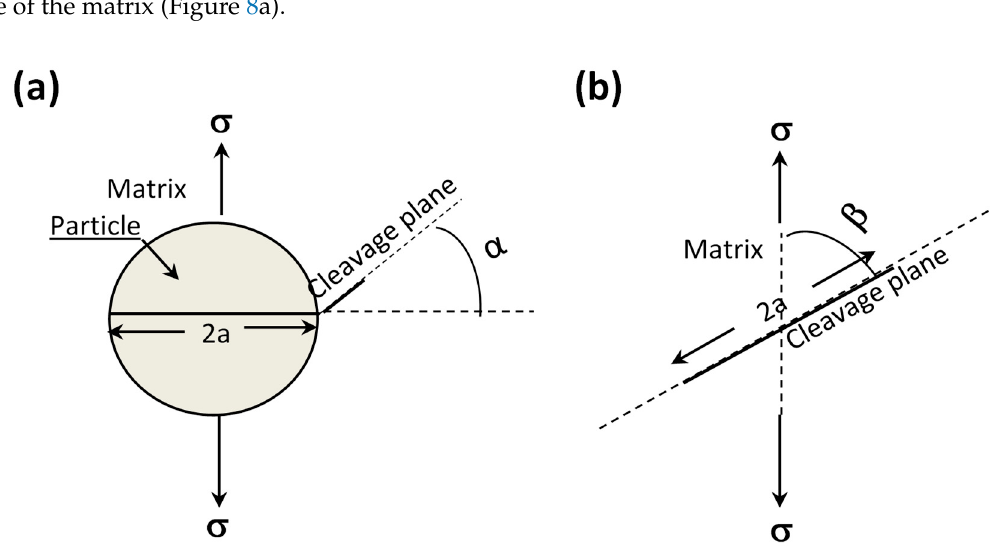
Figure 8. Scheme of the cracking models used to estimate the cleavage fracture strength: ( a ) kinked penny shaped cracking and ( b ) slanted penny shaped cracking.